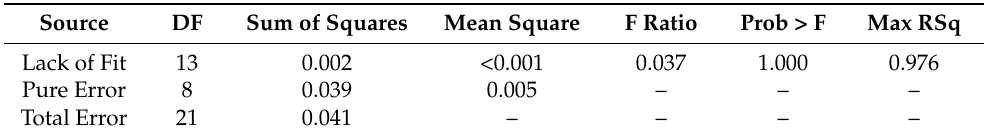
Table 11. Insufficient model fit error